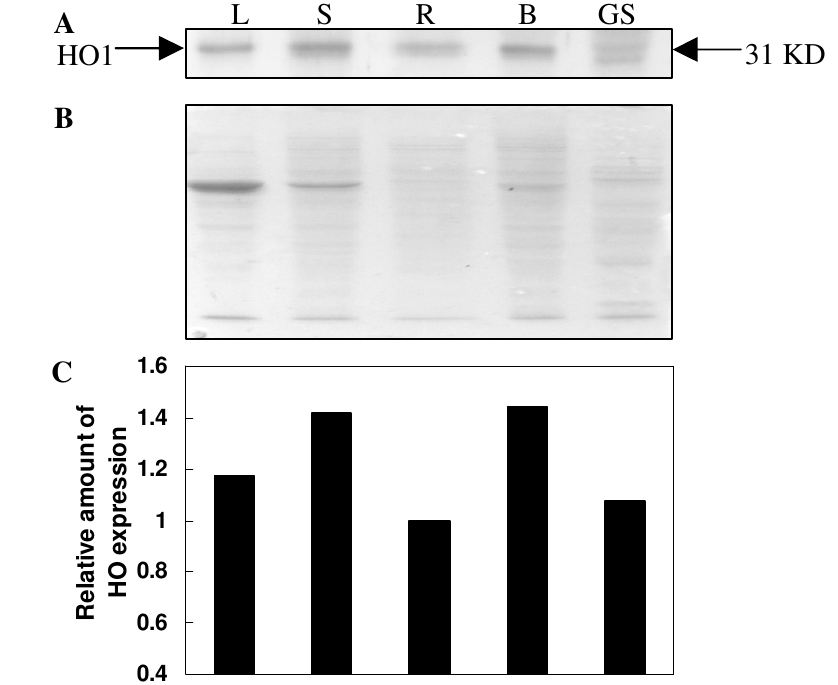
Figure 6. TaHO1 protein levels in various wheat tissues. Young leaves (L), stems (S), roots (R), and buds (B) were collected from 14-d-old seedlings under the normal growth conditions. Meanwhile, germinating seeds (GS) were sampled after 3 d of germination. Then, TaHO1 protein levels were determined by protein gel blot analysis ( A ); Meanwhile, Coomassie Brilliant Blue-stained gels ( B ) were present to show that equal amounts of proteins were loaded. Densitometry was done by Quantity One software to quantify HO-1 protein level ( C ). Relative HO-1 protein level taking root sample (R) as